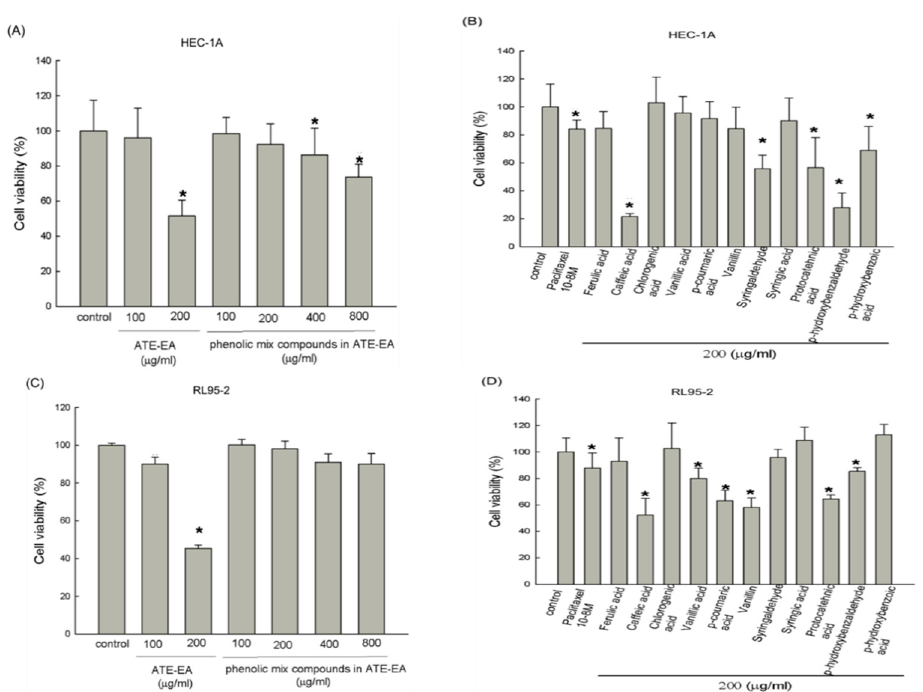
Figure 2. Effects of phenolic compounds from ATE-EA on the viability of HEC-1A and RL95-2 cells. HEC-1A cells were treated with serial concentrations of phenolic compound mixture ( A ) and its individual constituents at concentrations of 200 μ g/mL ( B ) of ATE-EA for 48 h. RL95-2 cells were treated with serial concentrations of phenolic compounds ( C ) and their constituents at a concentration of 200 μ g/mL ( D ). Cell viability was detected using an MTT assay. Data are expressed as means ± SD ( n = 3). * p < 0.05, compared with the control group at the basal level. ATE-EA, ethyl acetate fraction of the adlay extract.